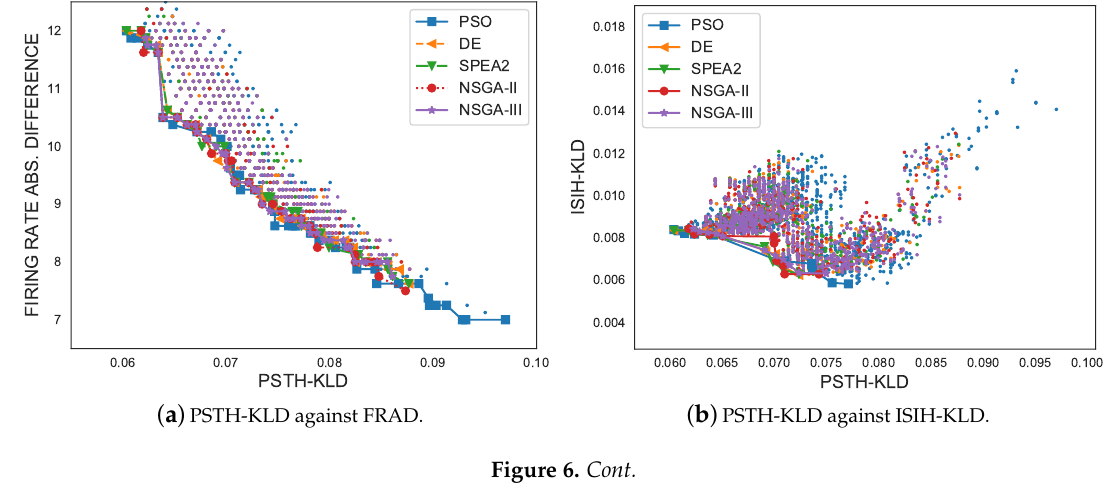
( b ) PSTH-KLD against ISIH-KLD. Figure 6.